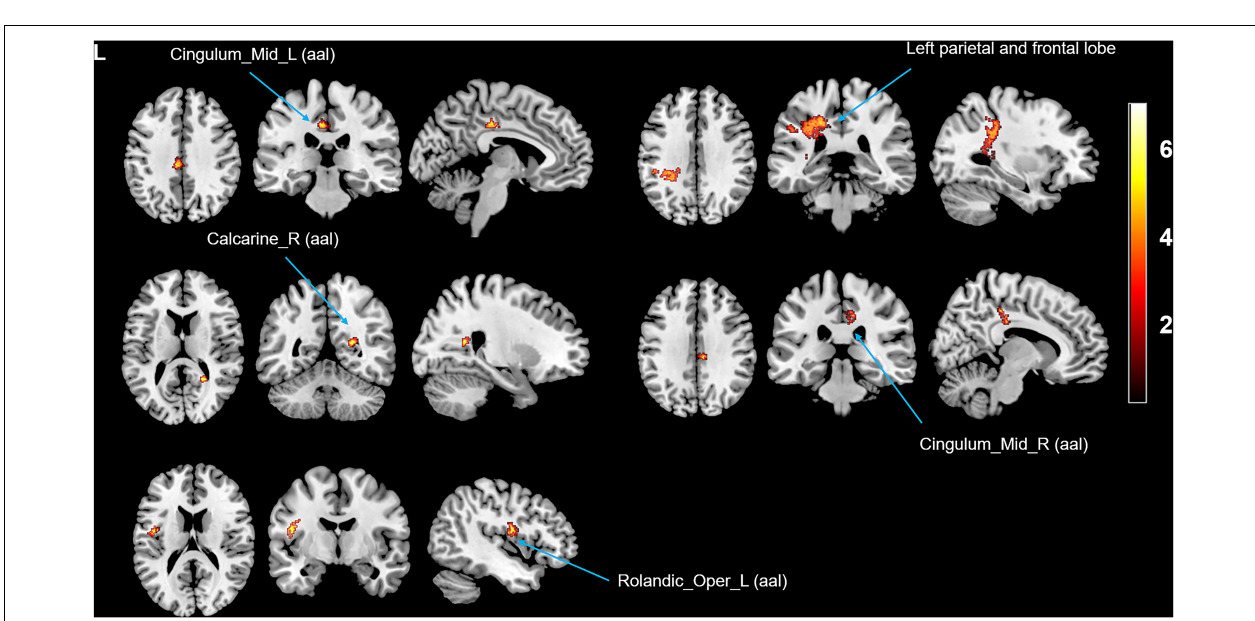
FIGURE 2 | Intergroup differences in WMV between the tinnitus patients without HL and HCs before and after sound therapy. At baseline, compared with the HCs, the patients with tinnitus without HL exhibited reduced WMV in the left MTG (corrected at non-stationary cluster level with FWE p < 0.05). After sound therapy (treated), the brain region with decreased WMV was still the same area, but the trend in the WMV reduction had diminished (uncorrected). HL, hearing loss, HC, healthy control, MTG, middle temporal gyrus, FWE, family wise error, WMV, white matter volume. The color bar represents the extent of reduction in WMV.